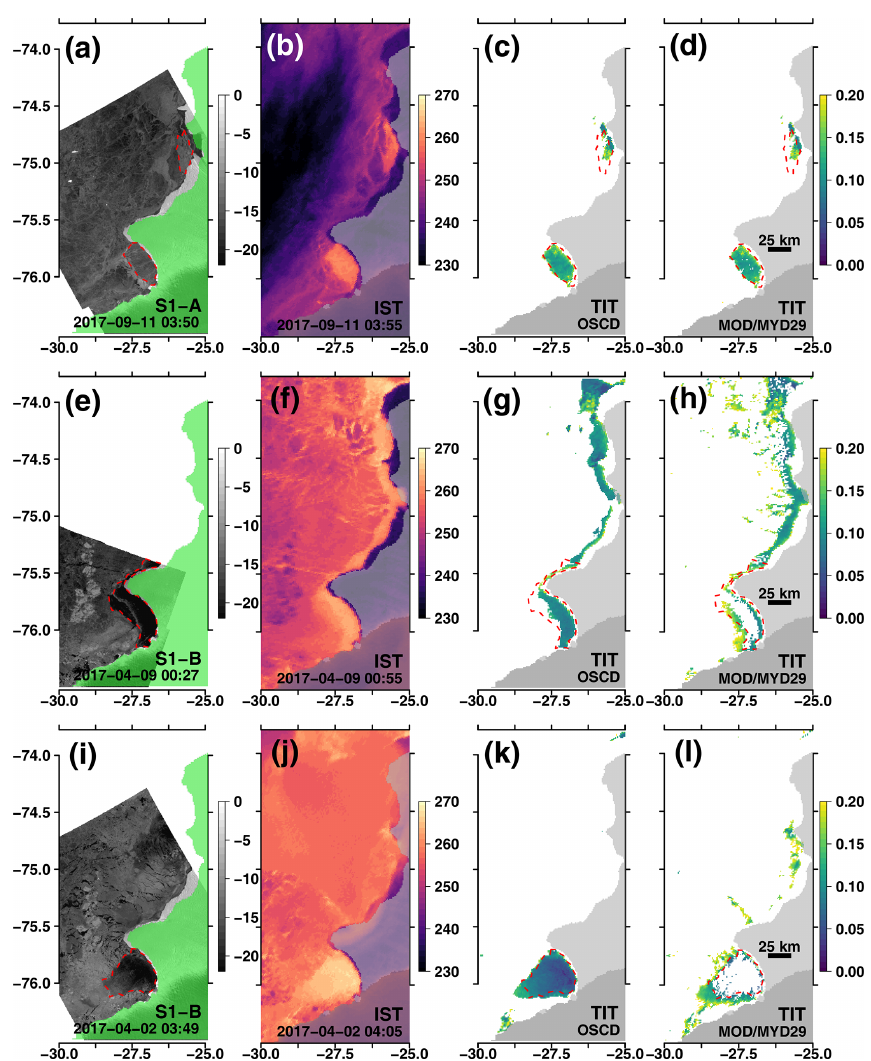
Figure 5. Additional compilation of exemplary co-located S1-A/B and MODIS swaths in the same setup as Fig. 4. Gray and green overlays highlight the ice-shelf extent. Manually picked S1-A/B reference polynya extent is outlined by a dashed red line in all panels. Please note that the date format in this figure is year month day (yyyy-mm-dd).